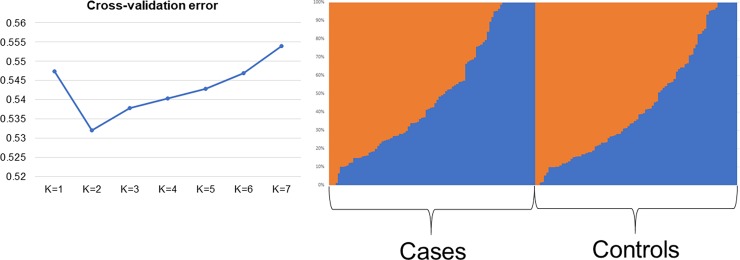
Admixture plot of the case-control dataset (showed on the right) using the K with the lowest cross-validation error (showed on the left).